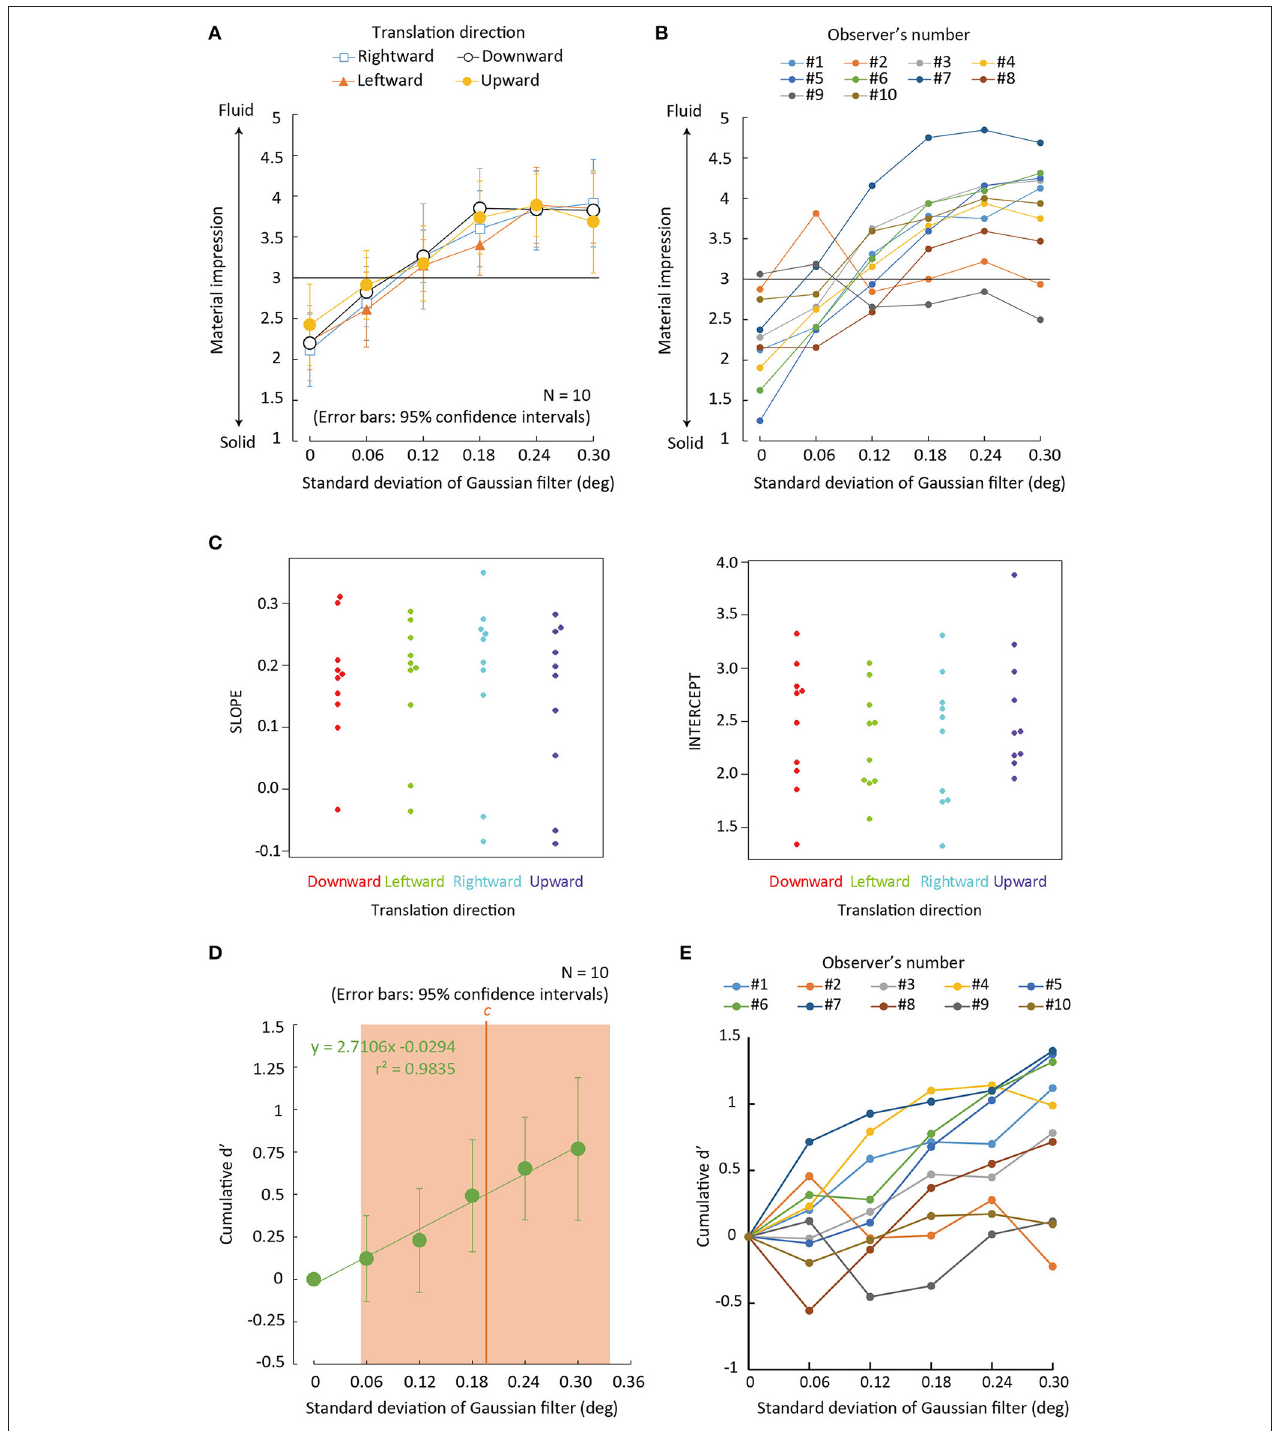
FIGURE 4 | Experiment 2 results. (A) Average rating of material impressions between solid (1) and fluid (5) as a function of the SD of the Gaussian blur filter that was applied to the contour of a deforming region. Error bars denote 95% confidence intervals ( N = 10). (B) Individual data of (A) wherein the condition of a translation direction is collapsed. (C) Beeswarm plots for the Individual slopes and intercepts of a linear function fitted to rating values as a function of the magnitude of the SD of Gaussian filter for each translation direction. (D) Green dots denote cumulative d ′ -value as a function of the magnitude of image deformation with 95 confidence intervals around the mean cumulative d ′ for each level of contour deformation, collapsed across translation directions ( N = 10). An orange vertical line denotes a decision criterion c between rating scores of “3” and “4.” An orange rectangular region denotes 95% confidence intervals of around the mean c for each level of the SD , collapsed across translation directions ( N = 10). (E) Individual cumulative d ′ as a function of the SD of the Gaussian blur filter.